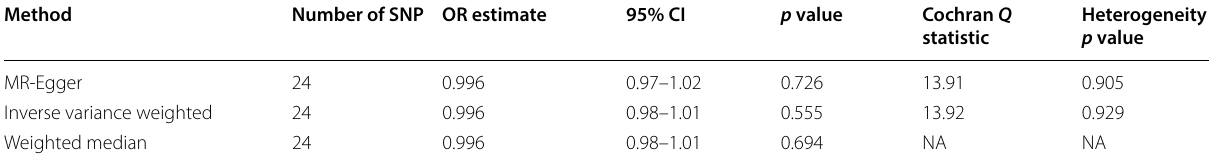
CI, confidence interval; MR, Mendelian randomization; NA, not available; OR, odds ratio; SNP, single nucleotide